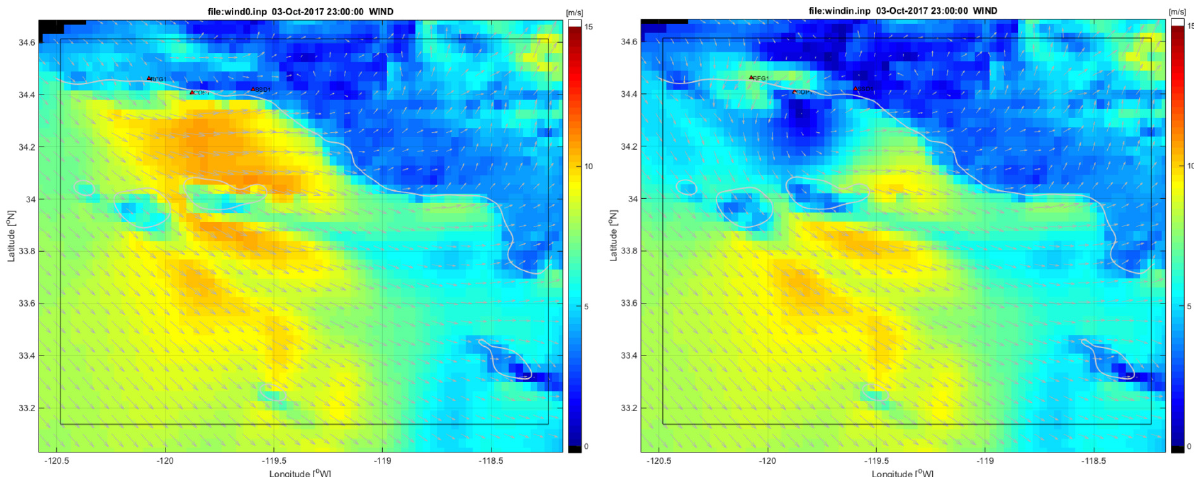
Figure 5. Wind comparison for U and V 10-m winds for NDBC buoy 46053 (blue circles), COAMPS first guess (red) and SWAN HF assimilation model (green) over the first 23 days of October 2017. In order to construct a continuous wind record from the 24-hour assimilation cycles, only the middle 12 h from each cycle were used.